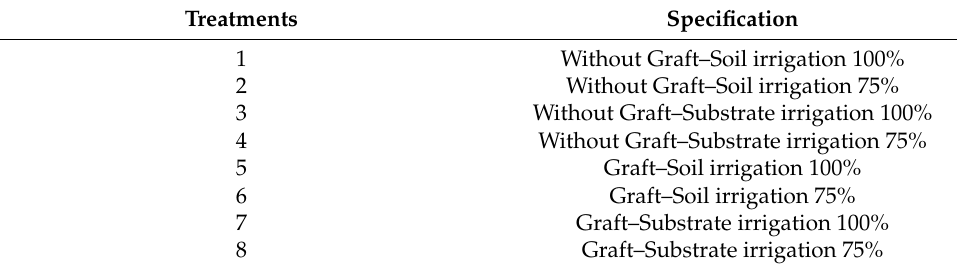
Table 1. Treatments used in the